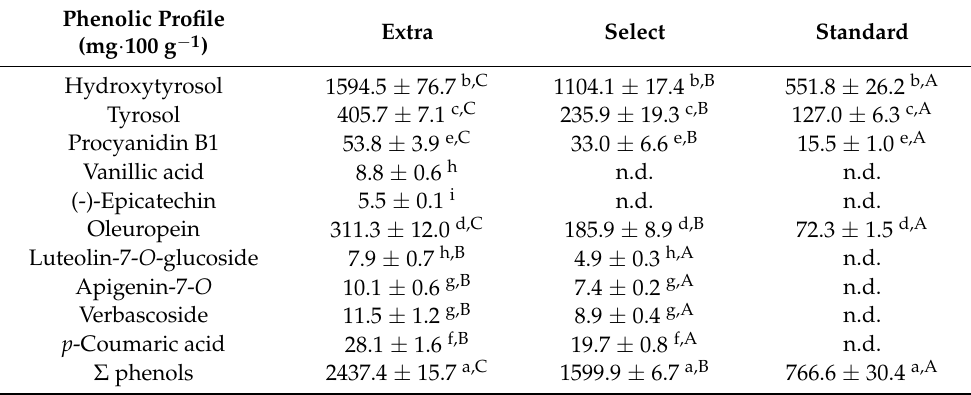
Table 3. Chemical composition of Californian-style black olives stuffed with natural